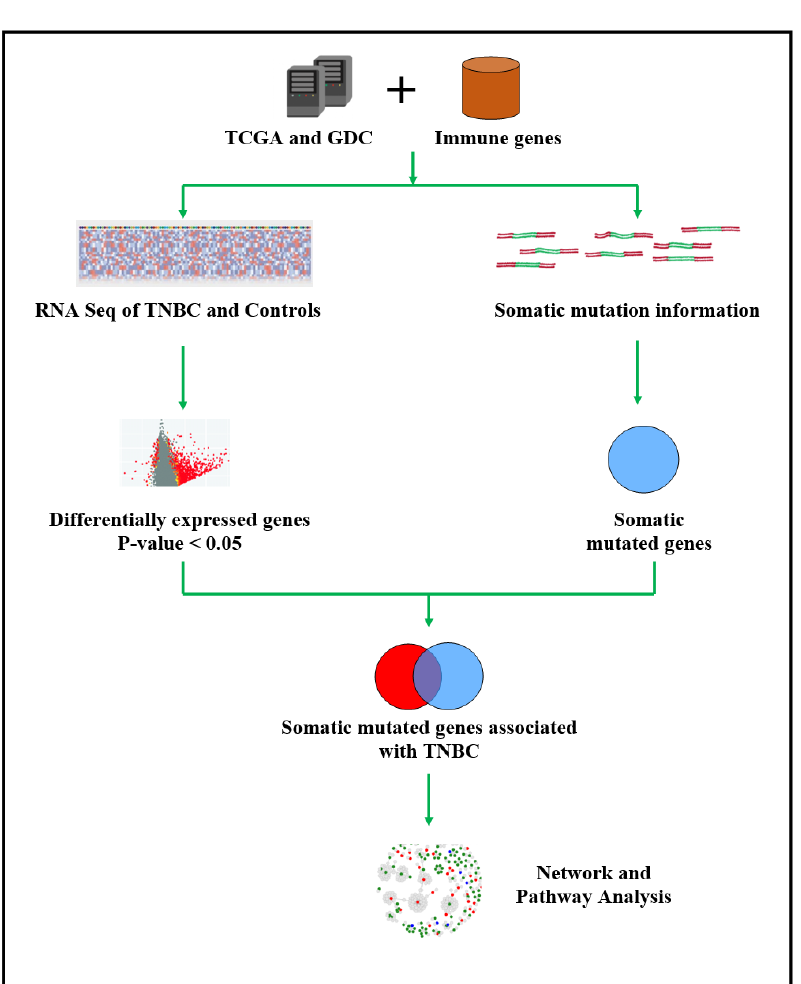
Figure 1. Overall project design, data processing and analysis workflow for the discovery of somatic mutated immune-modulated signatures of genes transcriptionally associated with TNBC, signatures predictive of clinical outcome; and immune-modulated gene regulatory networks and signaling pathways enriched for somatic mutations. In the figure, TCGA indicates The Cancer Genome Atlas, GDC indicates Genomics Data Commons, TNBC indicates triple-negative breast cancer, STN indicates solid tissue normal, DE indicates differentially expressed and DM indicates differentially mutated.